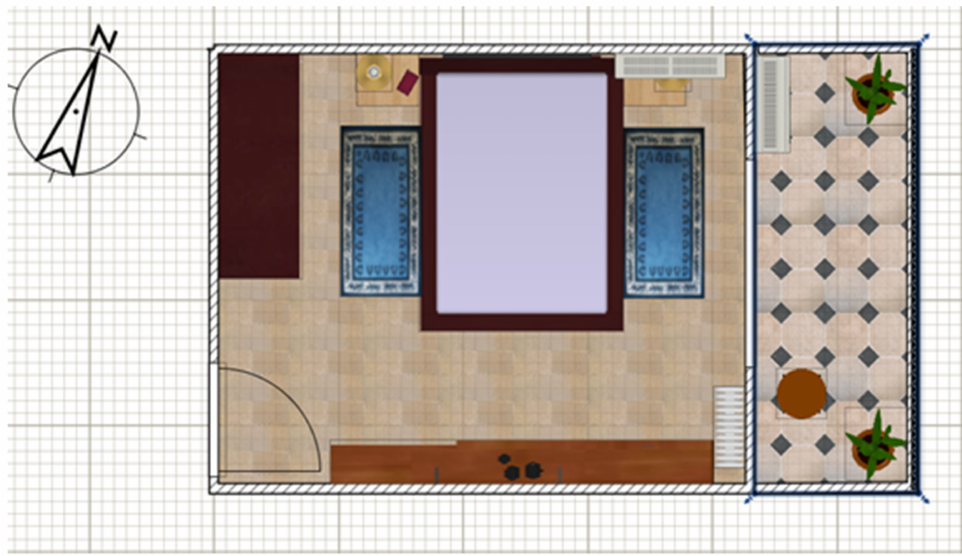
Figure 1. Room apartment floor plan.